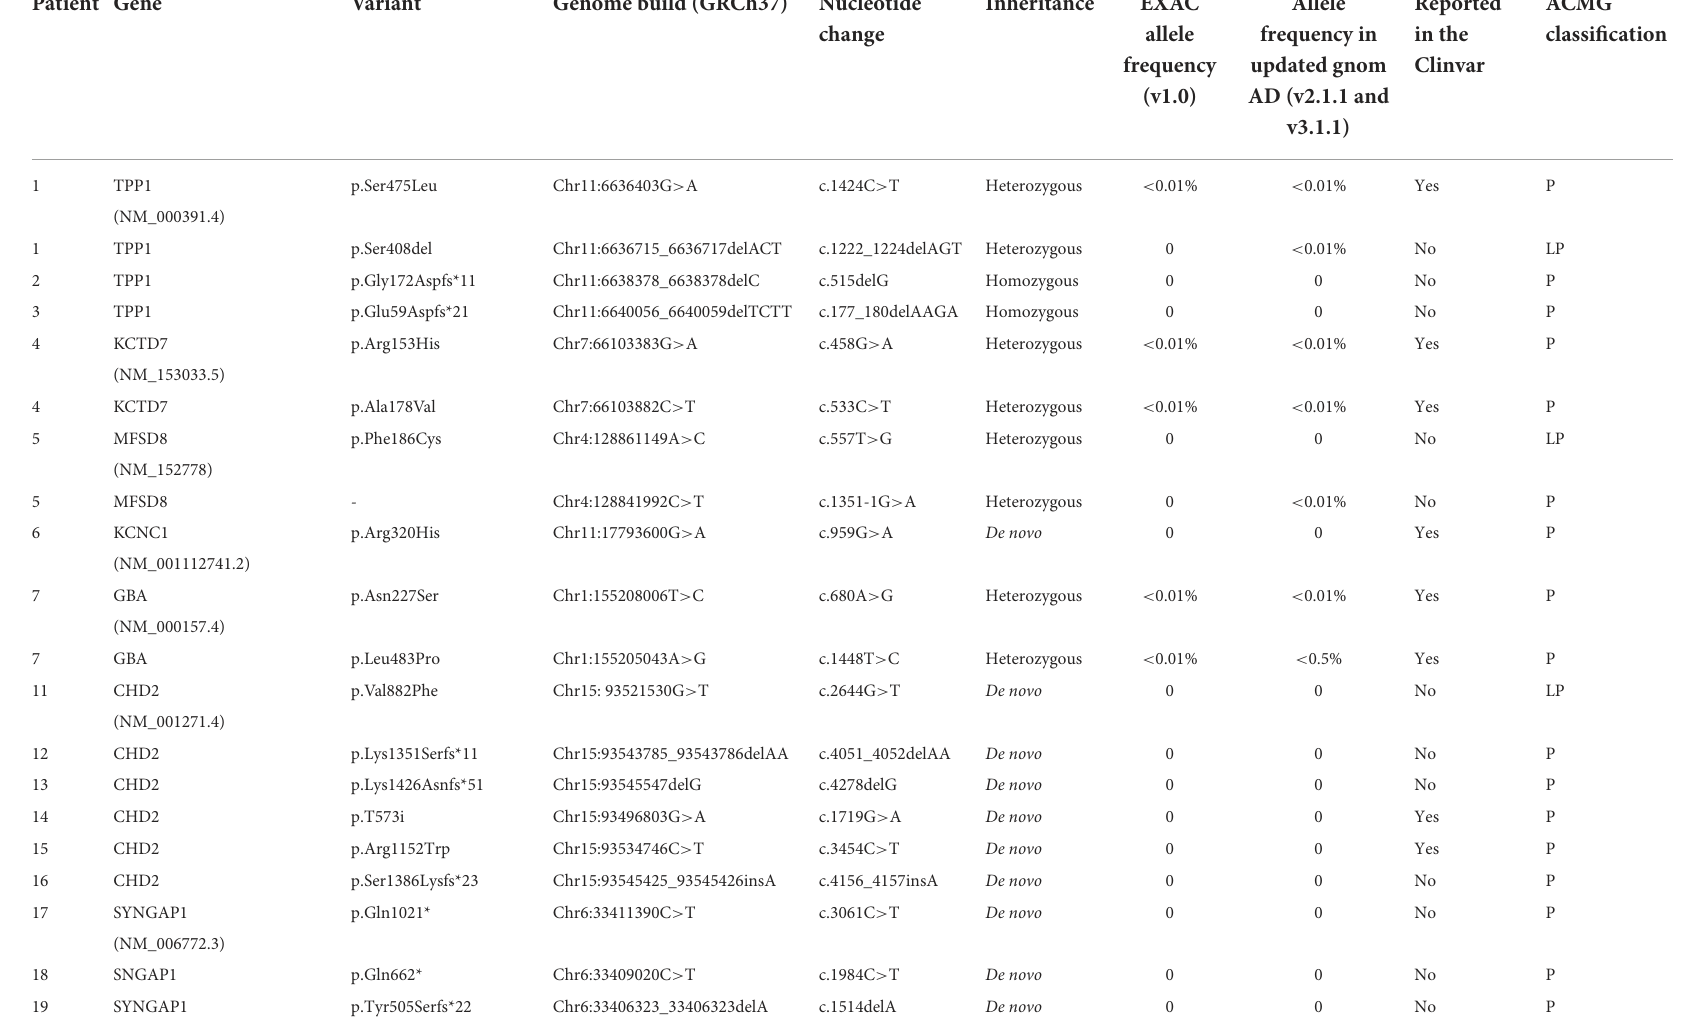
TABLE 2 Pathogenicity analysis of monogenic variants in epilepsy with photosensitivity. Patient